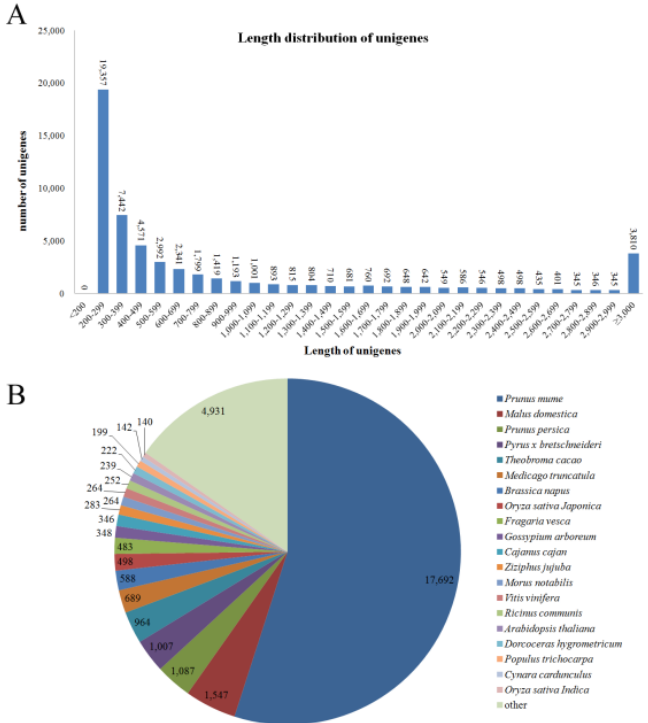
Figure 2. The distribution of the unigenes in ‘Huaxiu’ plums fruit transcriptome. ( A ): Sequence length distribution of the unigenes in ‘Huaxiu’ plums fruit transcriptome. The x -axis indicates unigene length interval from 200 bp to >3000 bp. The y -axis indicates the number of unigenes of each sequence length. ( B ): Results of species distribution of ‘Huaxiu’ plums unigenes top BLAST hits for all homologous sequences in NR (NCBI nonredundant) database. Different species are indicated by different colors. Table 1. Summary of sequencing and de novo assembly results of unigenes.